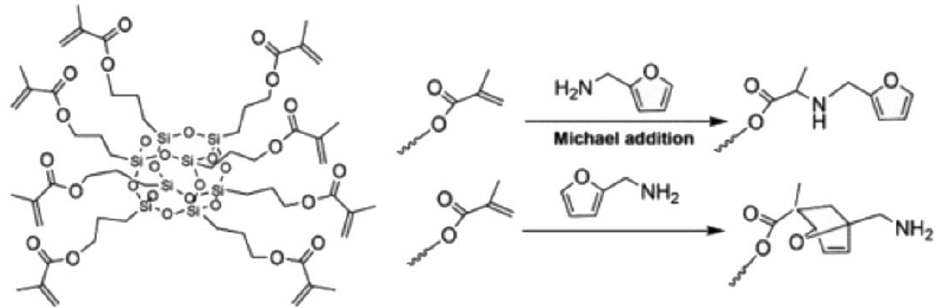
Figure 22. Chemical structures and reactions between MMA-POSS and FA. Reprinted from Compos. Sci. Technol . 2015, 118 , Chuo, T.-W.; Liu, Y.-L., Preparation of self-healing organic-inorganic nanocomposites with the reactions between methacrylated polyhedral oligomeric silsesquioxanes and furfurylamine, 236 – 243, [84]. Copyright (2015), with permission from Elsevier.